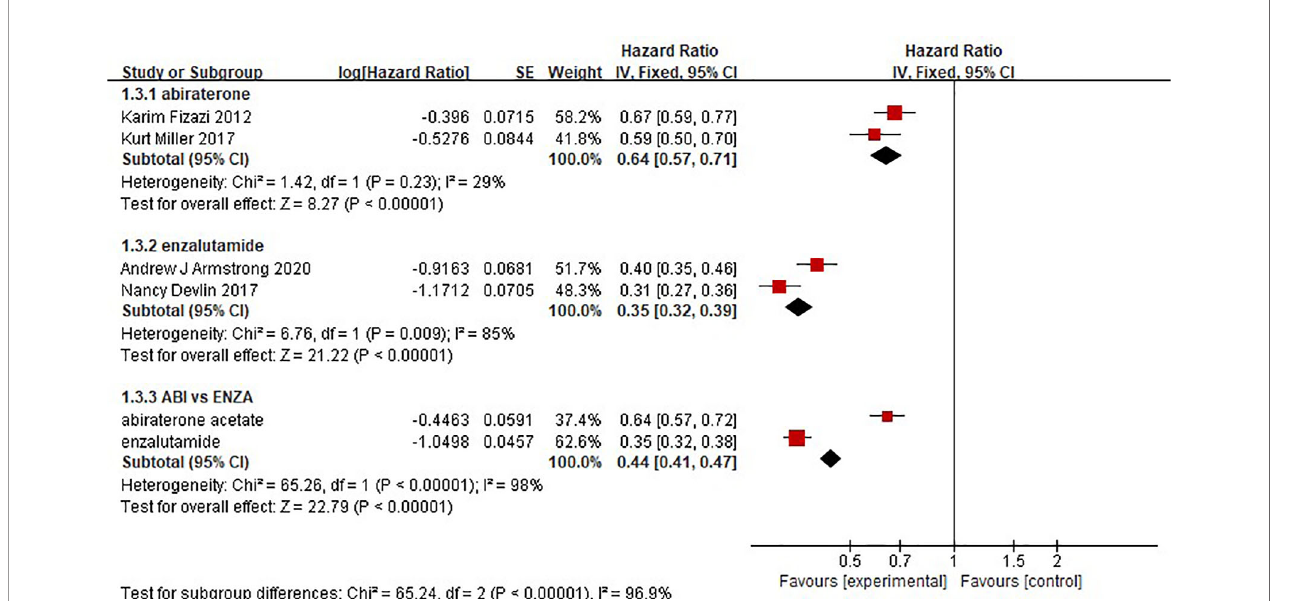
FIGURE 6 | Forest plots for radiographic progression-free survival in studies.